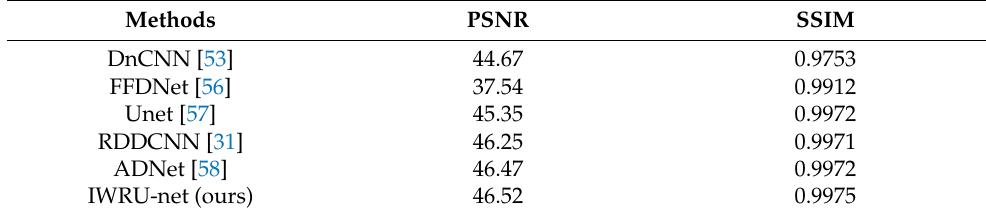
Table 4. Average PSNR (dB) and SSIM of different networks on CLWD datasets for varying trans- parency rates of 0.5, 0.6, 0.7 and 0.8.